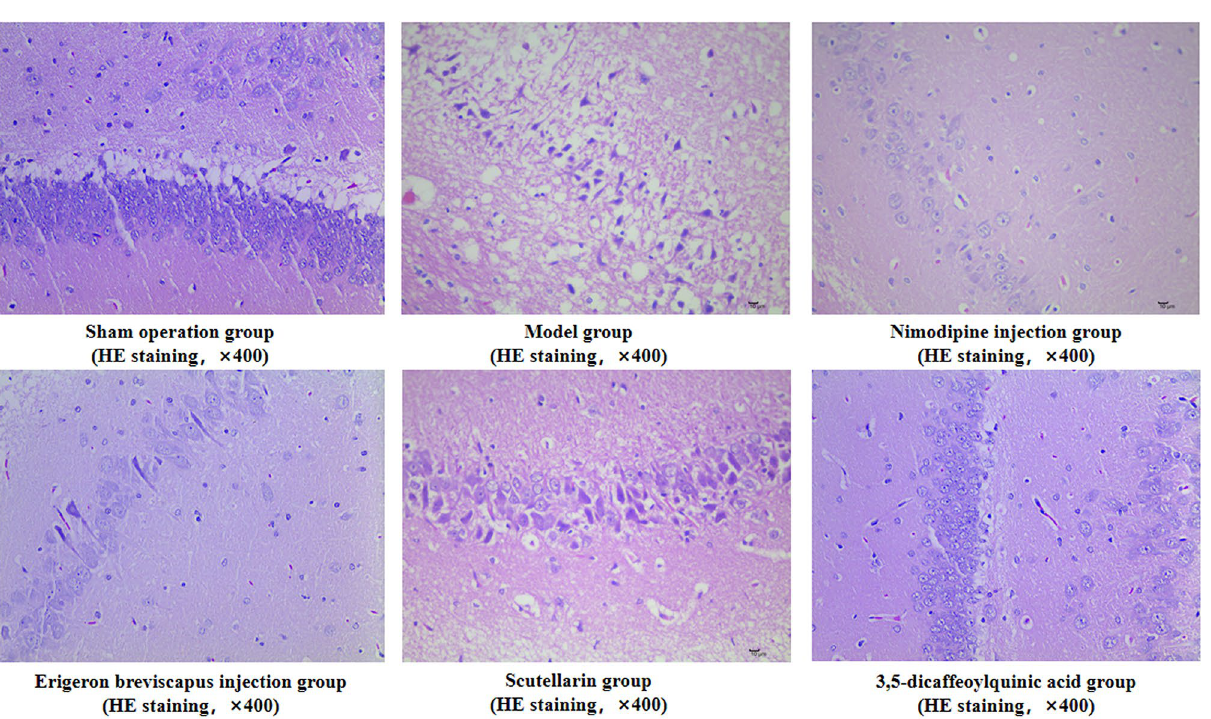
Table 3. Histopathological ischemic brain changes in rats. *Compared with the model group, * P < 0.05 and ** P < 0.01.